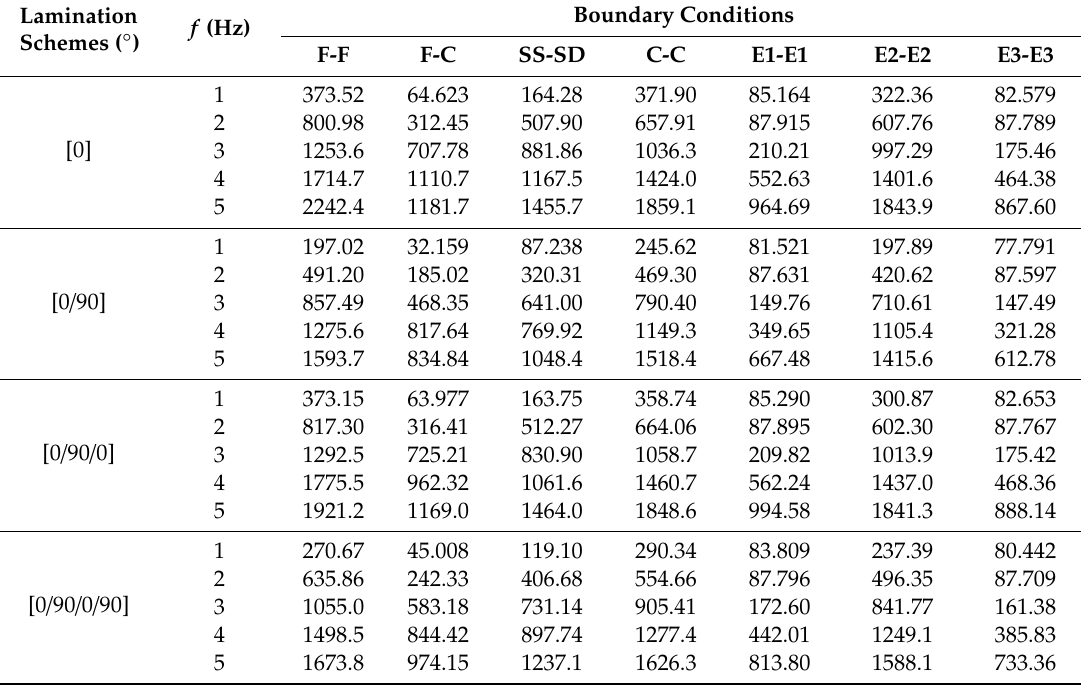
Table 6. Frequencies (first five modes) for a paraboloidal curved laminated composite beam with diverse lamination schemes and boundary